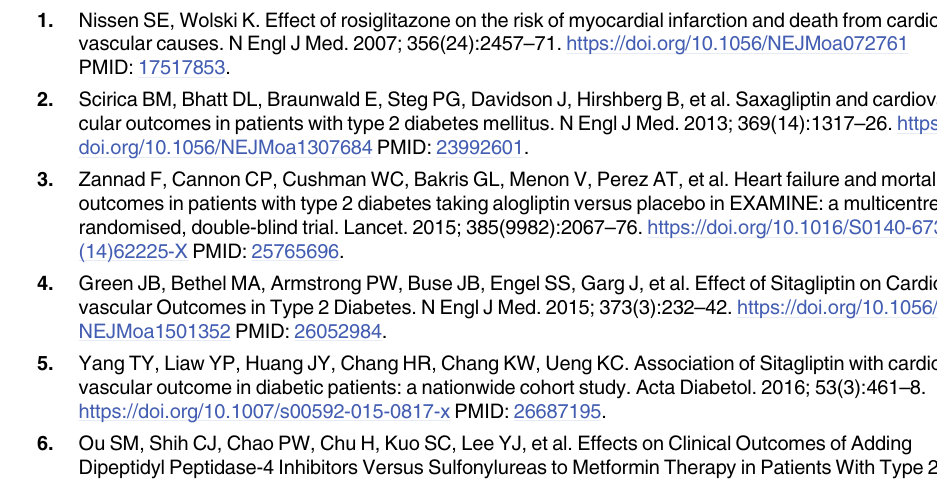
S4 Table. Subgroup analysis-hHF in non-CKD population. S5 Table. Subgroup analysis-MACE in CKD population. S6 Table. Subgroup analysis-MACE in non-CKD population. S7 Table. Subgroup analysis-ischemic stroke in non-CKD